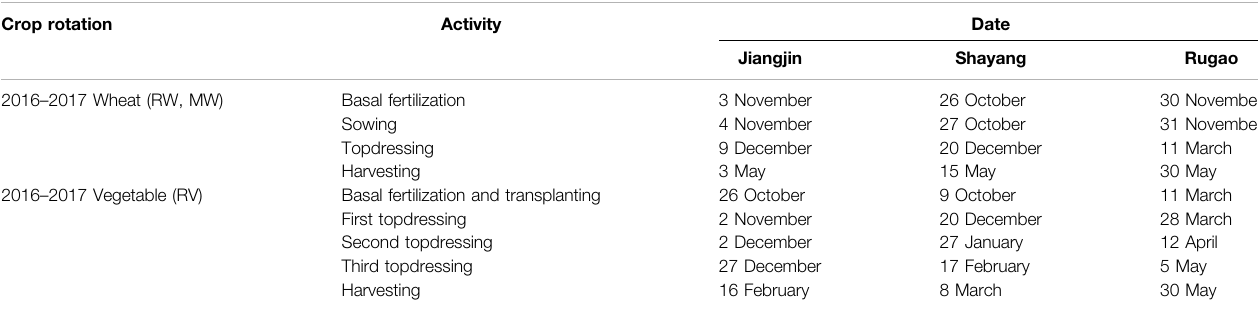
TABLE 3 | Agricultural management during the winter season at the three sites. Crop